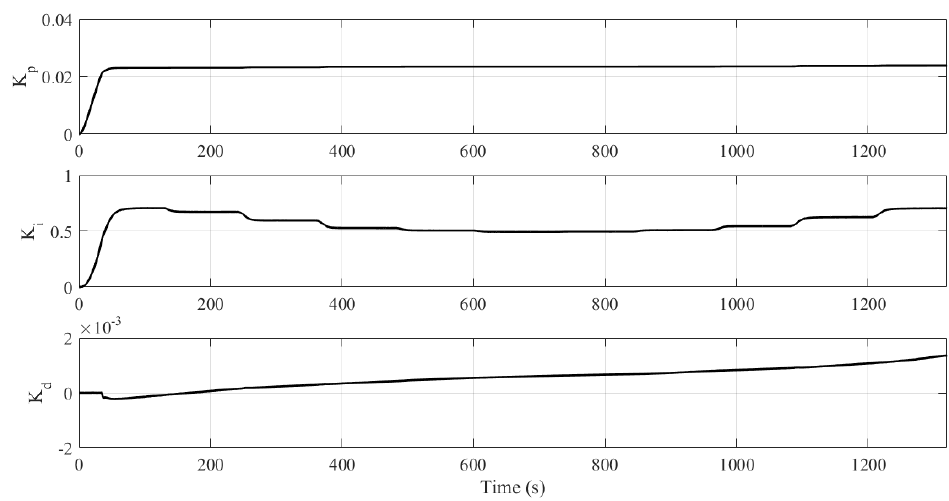
Figure 12. Evolution of controller parameters (Experiment